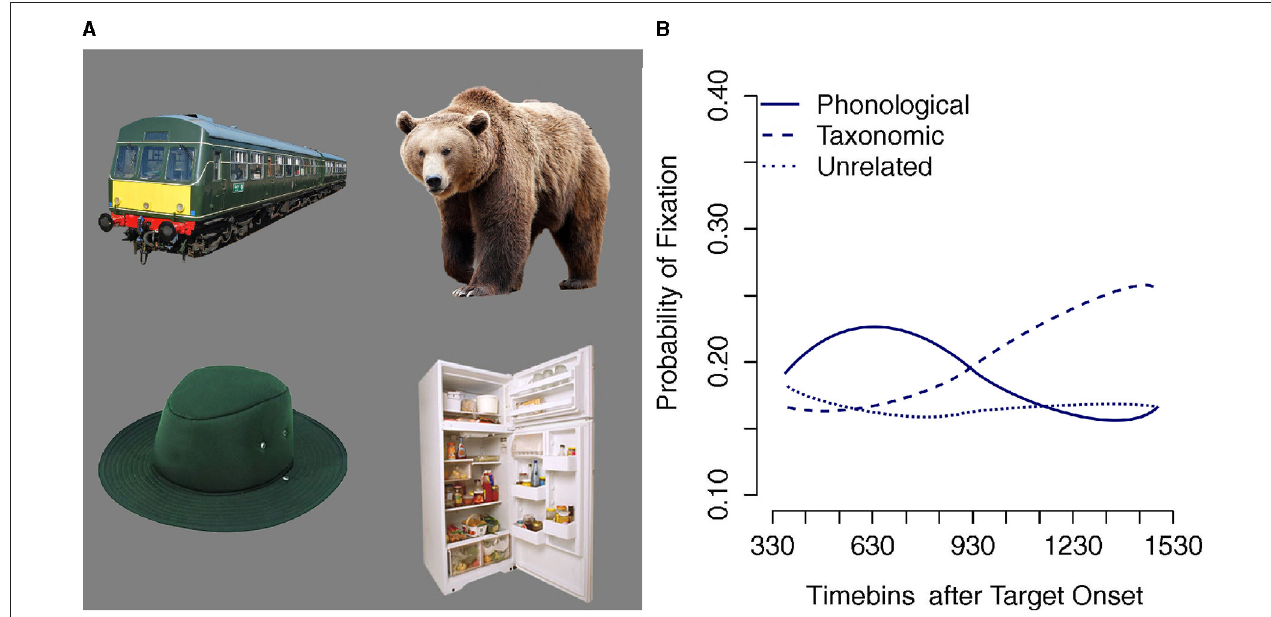
FIGURE 1 | (A) Example of the type of display used in visual world tasks (Huettig and McQueen, 2007; Chow et al., 2017). (B) Successive fixation of phonological and semantic foils in a 4-picture visual world task by 30-month old toddlers, adapted from Chow et al.